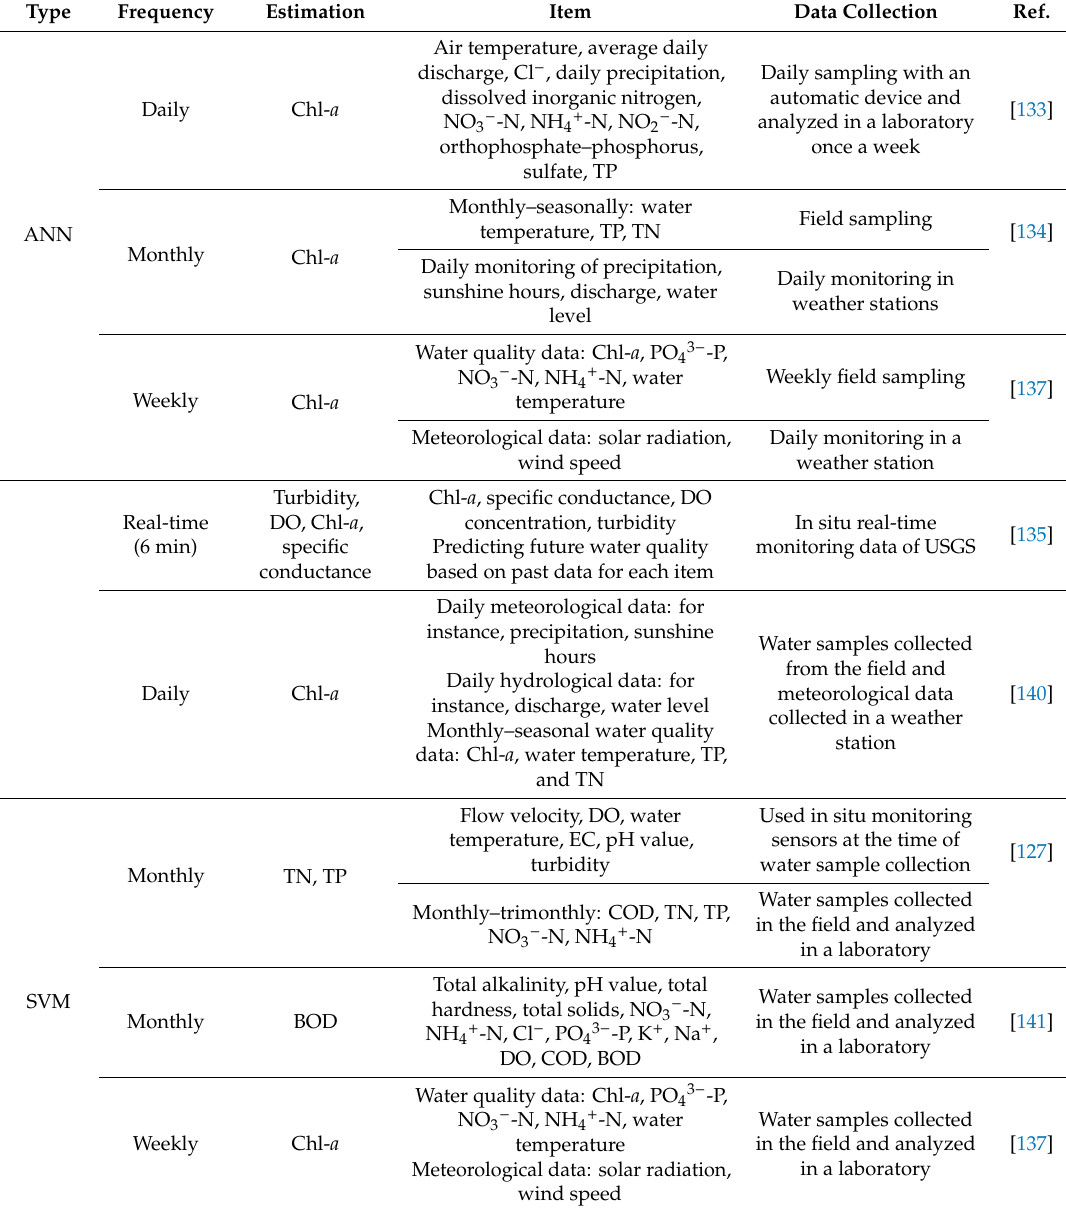
Table 3. Examples of machine-learning application cases for water quality